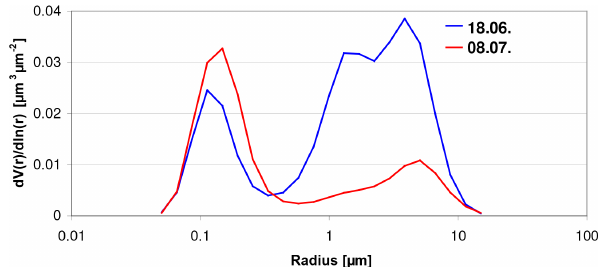
Figure A32. Size distributions derived from AERONET Almucan- tar observations on 18 June (07:24 and 15:34) and 8 July (07:32 and